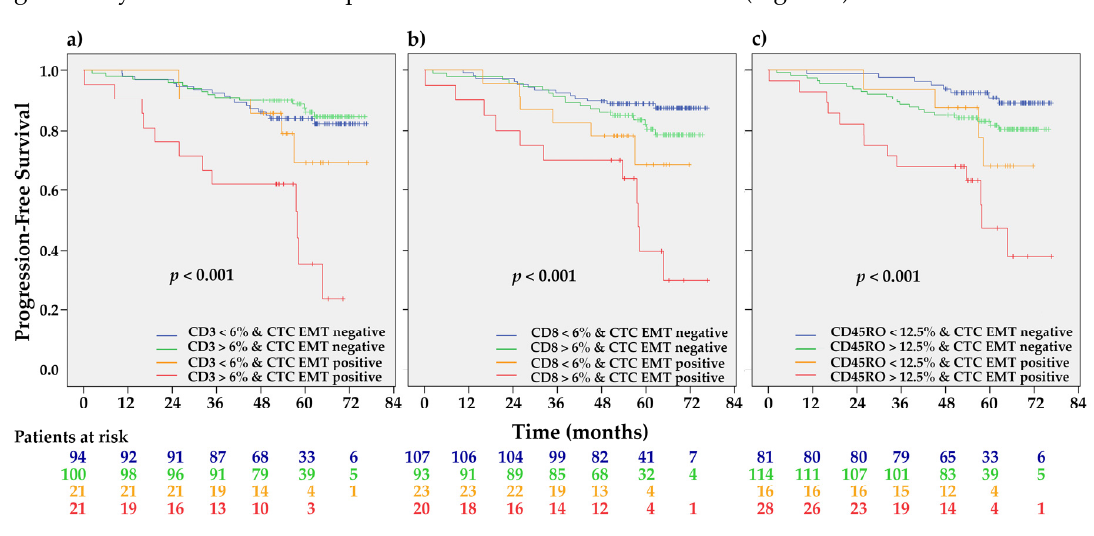
Figure 4. The Kaplan-Meier PFS estimates for CTC EMT stratified by individual stromal TILs categories. CTC EMT positive patients with ( a ) CD3 high , ( b ) CD8 high , and ( c ) CD45RO high stromal infiltration had significantly shorter PFS than all other combinations ( p ≤ 0.001 for CD3, CD8, and CR45RO, respectively, by the Log-rank test).